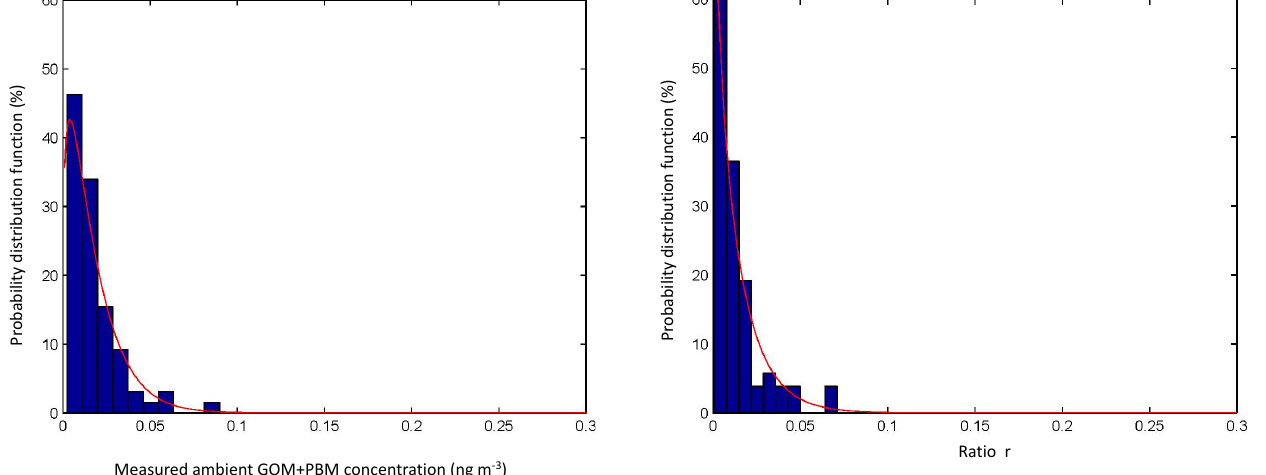
Fig. 2. Same as in Fig. 1 except for ratio r defined in Eq. (4). Table 2. Fitted beta distribution of the ratio r defined in Eq.